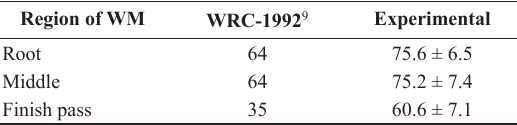
Table 3. Comparison between experimental and predicted austenite volume fraction. Region of WM